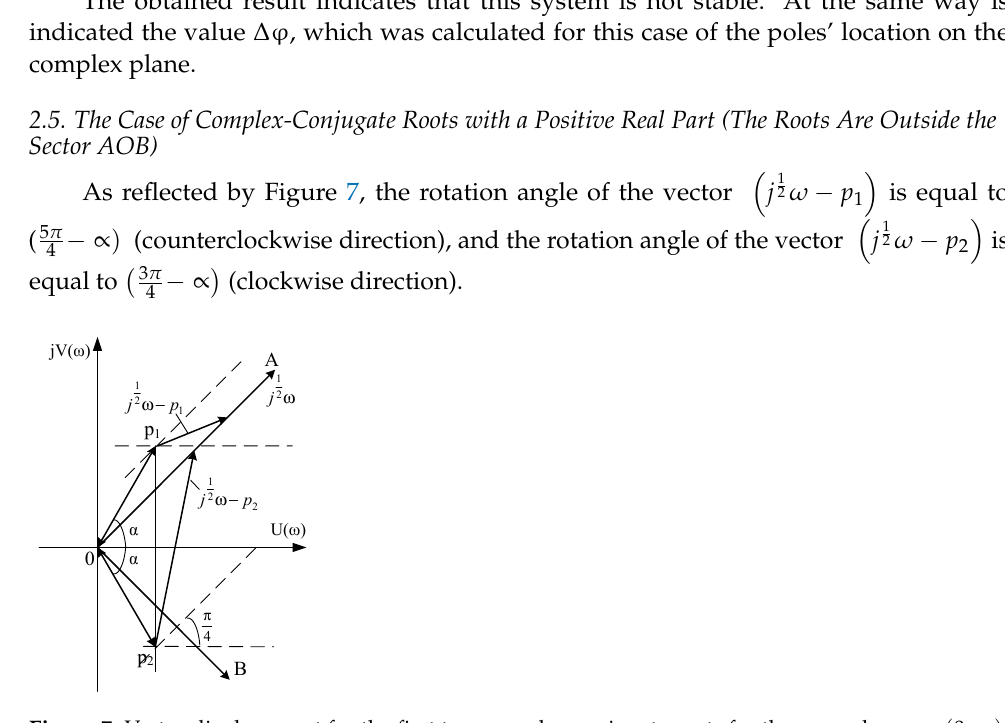
Figure 7. Vector displacement for the first two complex-conjugate roots for the case when 𝜔 𝜖 (0, ∞) .